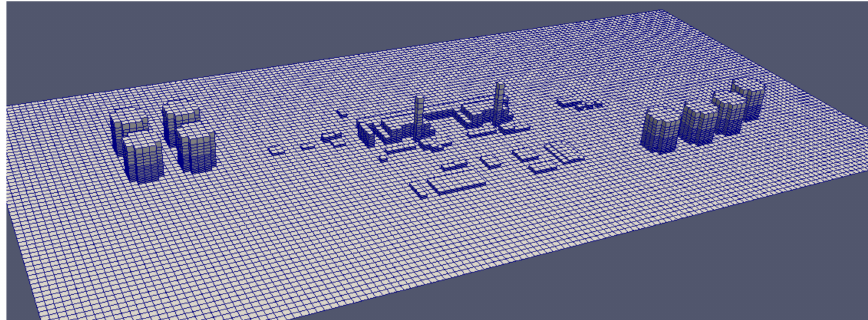
Figure 1. 3D model of the area of the Mochovce nuclear power plant,